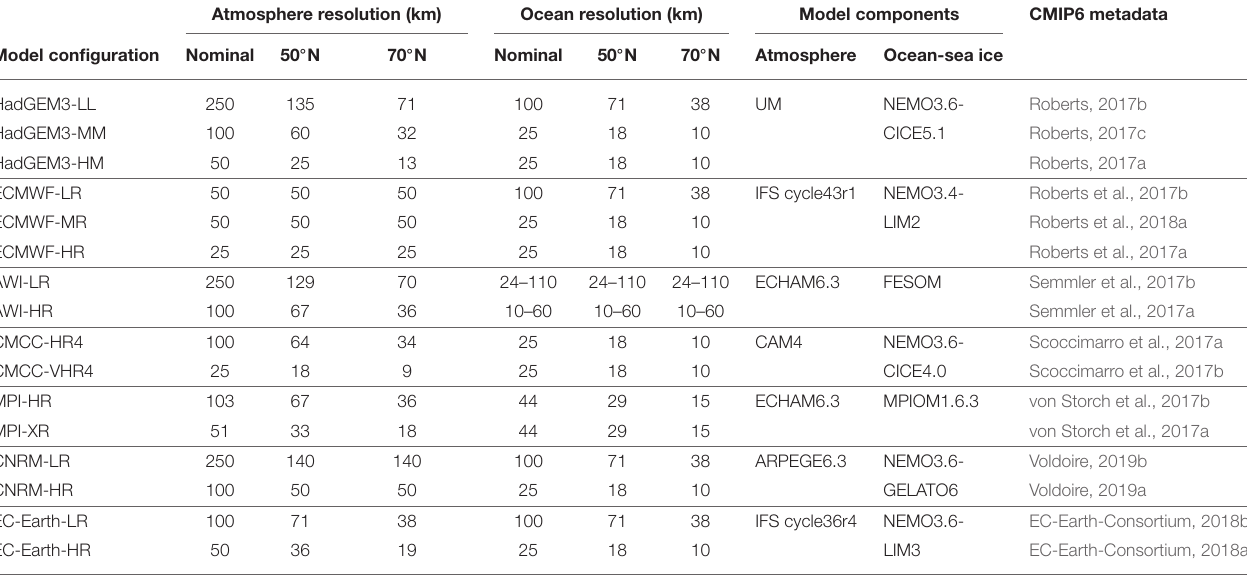
TABLE 1 | Atmosphere and ocean resolutions (in km) of the model configurations used in this study. Atmosphere resolution (km) Ocean resolution (km) Model